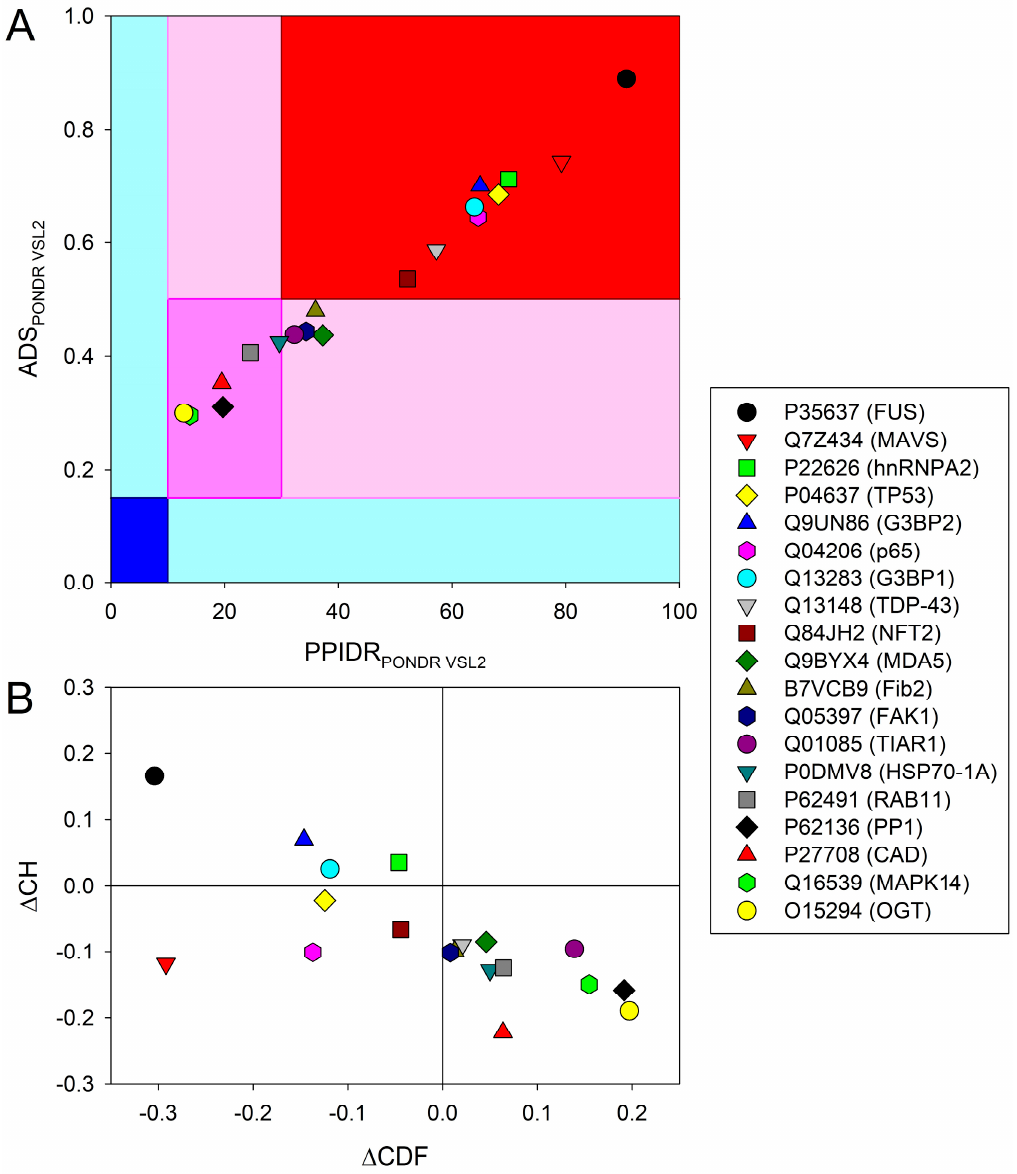
Figure 1. Global intrinsic disorder predisposition of 19 eukaryotic proteins recruited to the viral infection-related MLOs. ( A ). Analysis of query proteins based on the average disorder score (ADS) and percent of predicted disordered residues (PPIDR) as evaluated by PONDR ® VSL2. High values of each parameter correspond to high disorder propensities. Different color blocks indicate regions containing proteins with different levels of order, where mostly ordered, moderately disordered, and mostly disordered proteins are located within blue, pink, and red blocks, respectively. If the two parameters (ADS and PPIDR) agree, the corresponding part of the background is shown by a dark color (blue or pink), whereas light blue and light pink reflect areas in which only one of these criteria applies. ( B ). CH–CDF plot for 19 eukaryotic proteins recruited to the viral infection-related MLOs.